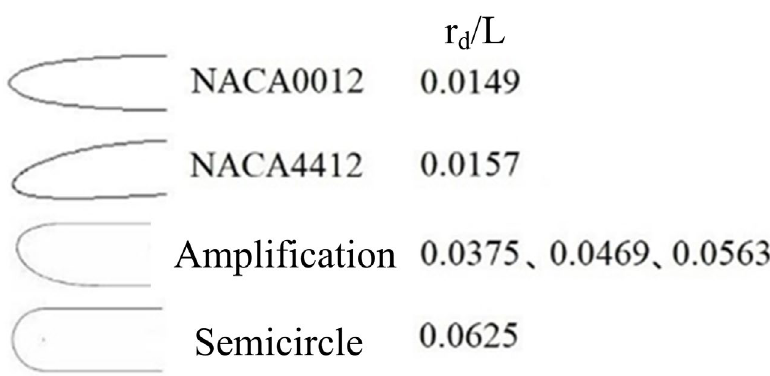
Figure 9. Four kinds of ducted fan lip shapes.